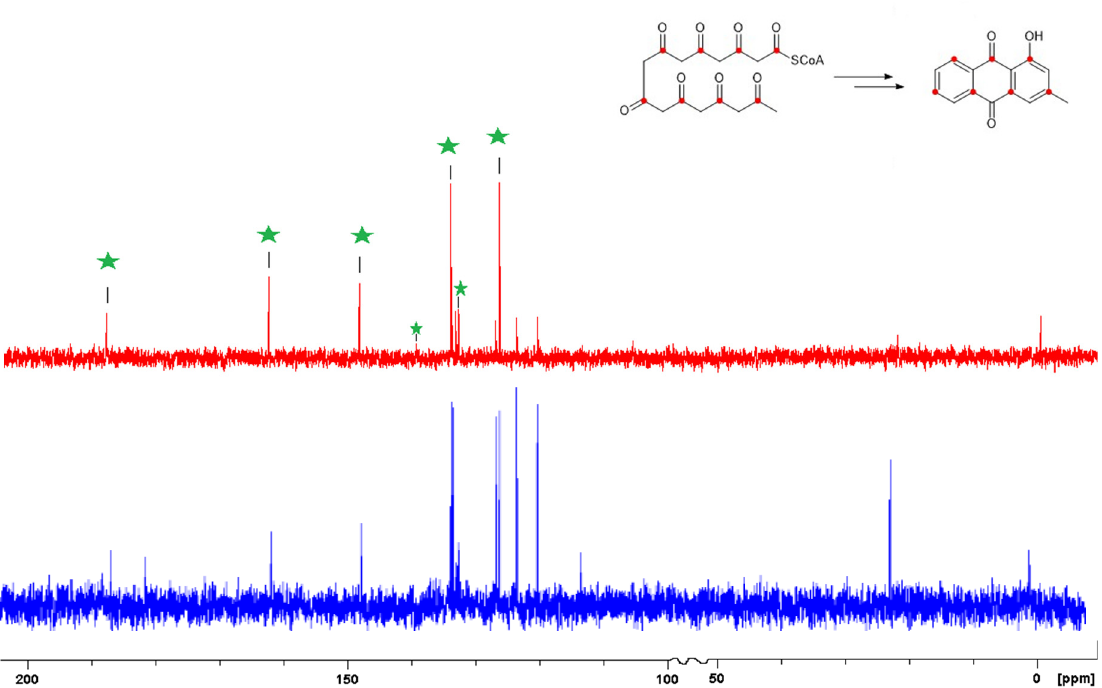
Figure 8. 13 C-NMR spectra of unlabelled (blue) and biosynthetically labelled (red) pachybasin. Green stars: 13 C enhanced carbon signals. Table 3. Assignment of 13 C-NMR resonances using labelled pachybasin ( 5 ) in comparison to literature.